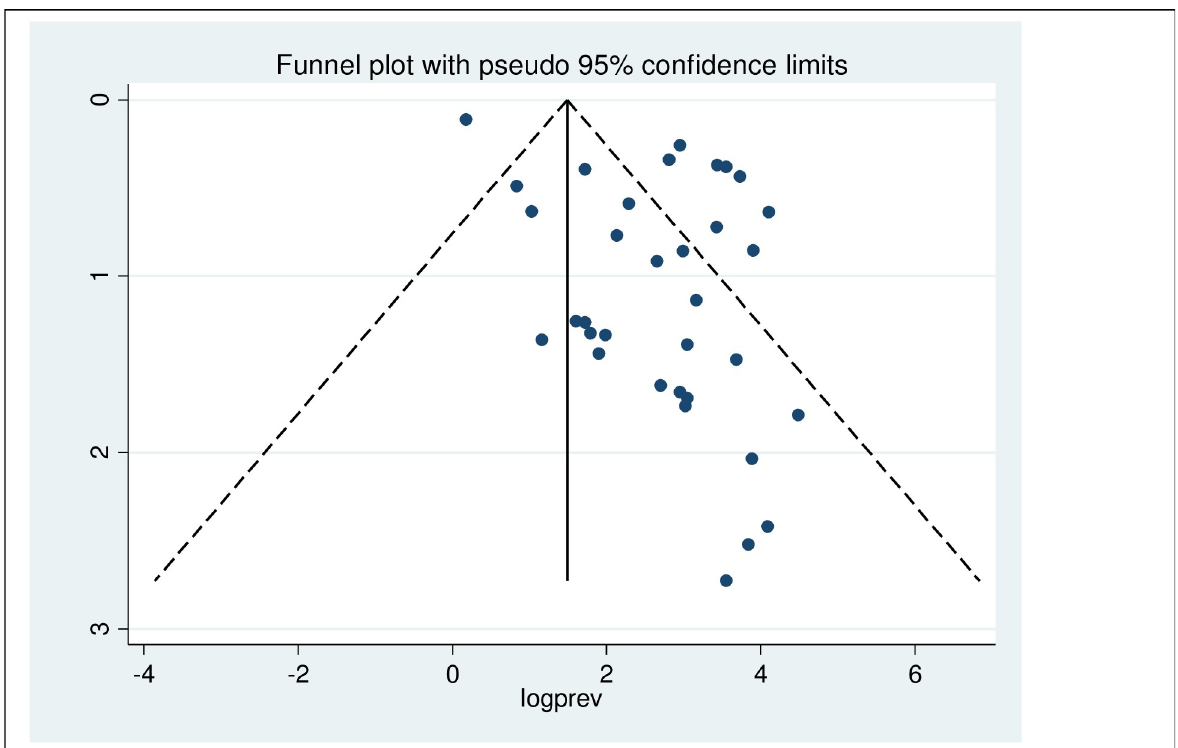
Fig 3. Funnel plot of included studies on the prevalence of HCV among